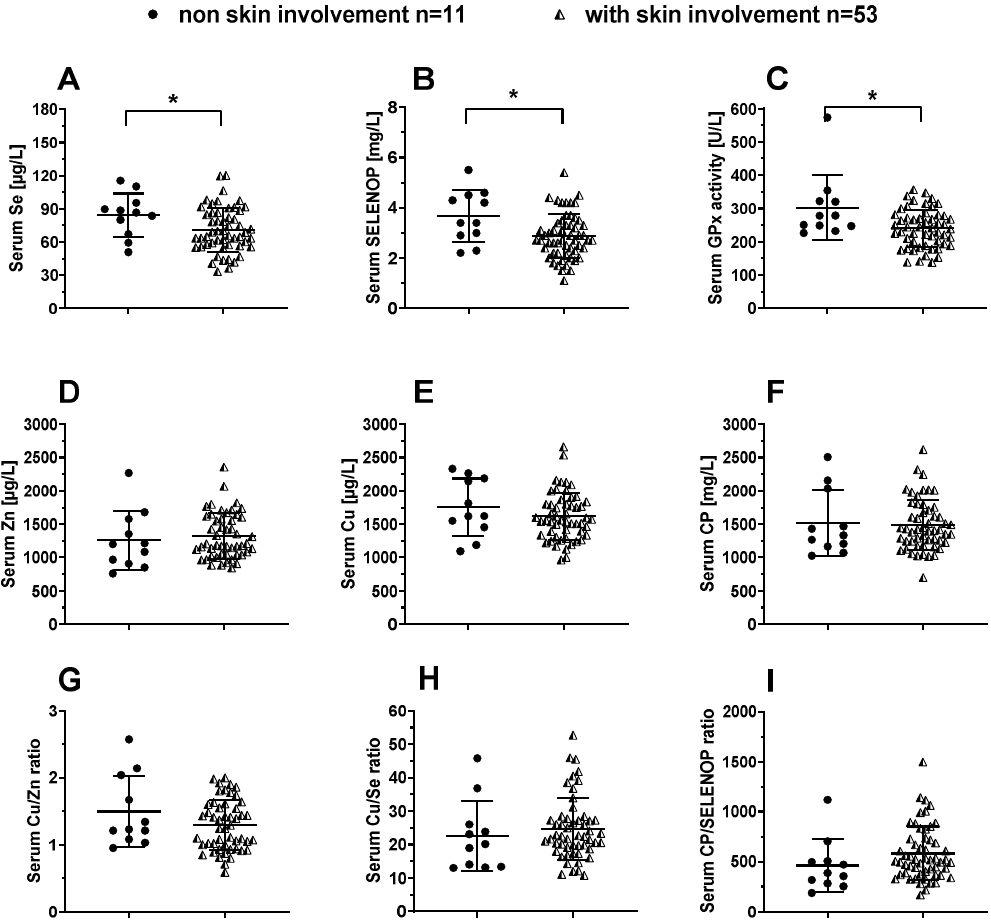
Figure 4. Comparison of TE biomarkers in SSc patients in relation to skin involvement. The average Se status is reduced in SSc patients with skin involvement as compared to the patients without skin involvement. The SSc patients with skin involvement display relatively low ( A ) total serum Se, and ( B ) SELENOP concentrations, as well as ( C ) reduced serum GPx3 activity, in comparison to SSc patients without skin involvement. No difference between the groups are observed for ( D ) total serum zinc (Zn), and ( E ) total serum Cu concentrations. Similarly, ( F ) serum ceruloplasmin (CP) concentrations, ( G ) the Cu/Zn, ( H ) Cu/Se, and ( I ) CP/SELENOP ratio do not differ between the groups. Comparisons between two groups were conducted by unpaired t test, and for not-normally distributed variables with Mann Whitney test. All tests were two-sided and p -values < 0.05 were considered statistically significant; * indicates p < 0.05.